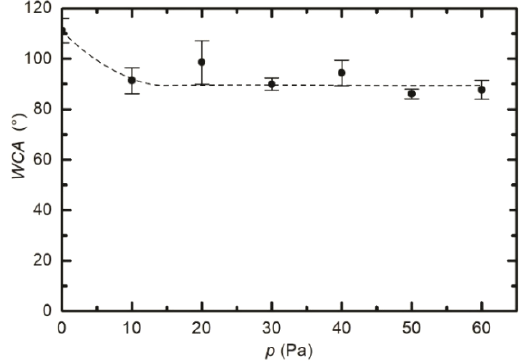
Figure 4. Variation of surface wettability with the forward discharge power. Treatment time and hydrogen pressure were constant at 1 s and 25 Pa, respectively.